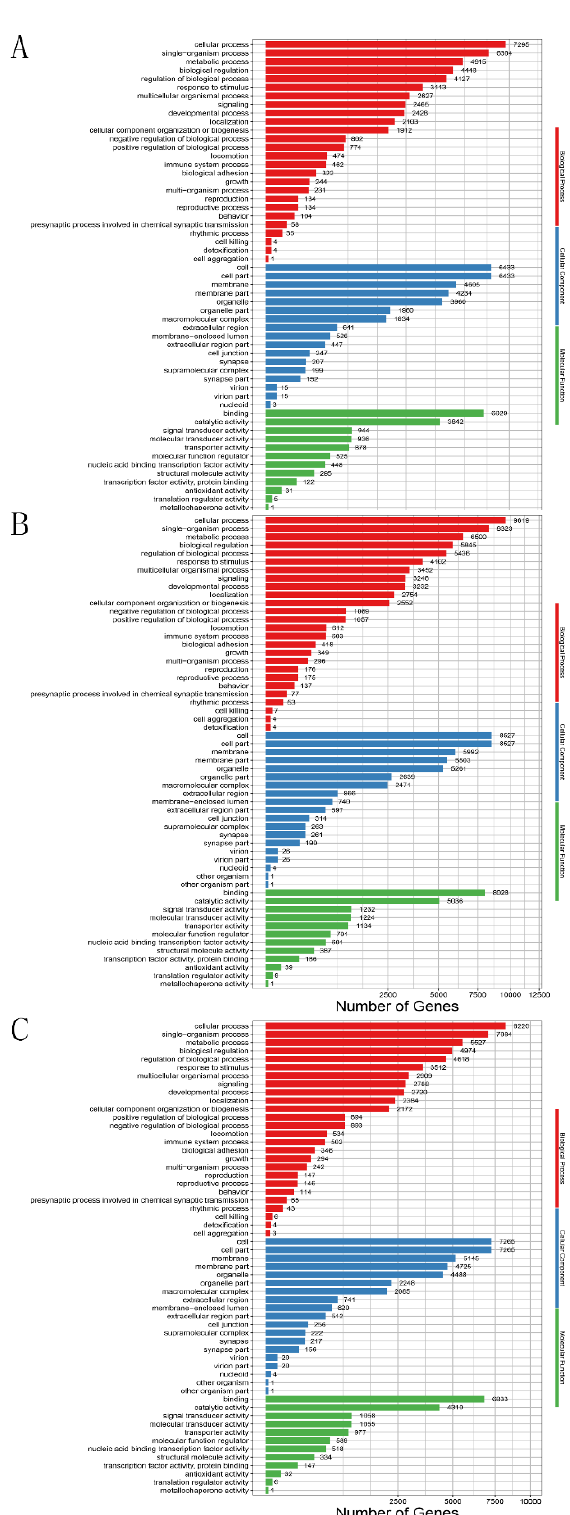
Figure 3. GO function classification of the differentially expressed genes comparison between the groups. ( A ) T0 vs. T1, ( B ) T0 vs. T2, ( C ) T0 vs. T3. The x-axis represents the number of genes and the y-axis represents different Gene Ontology (GO) term functional classification.